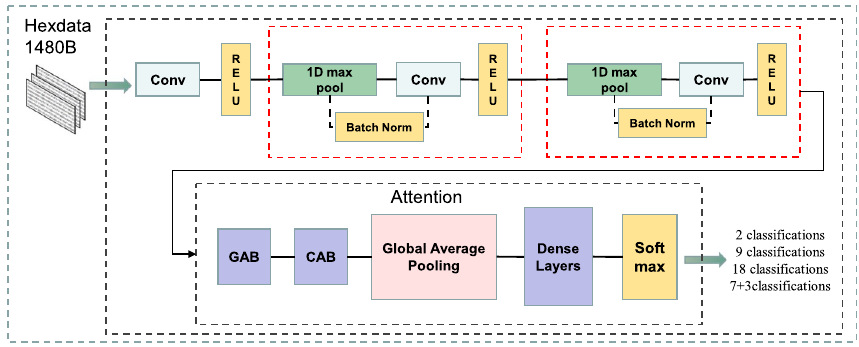
Fig. 1 HexCNN-1D Model Flow